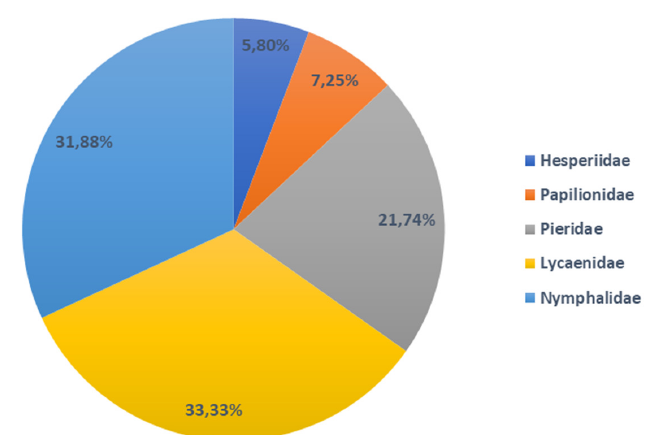
Figure 2. Family-wise distribution of butterfly species in the study area